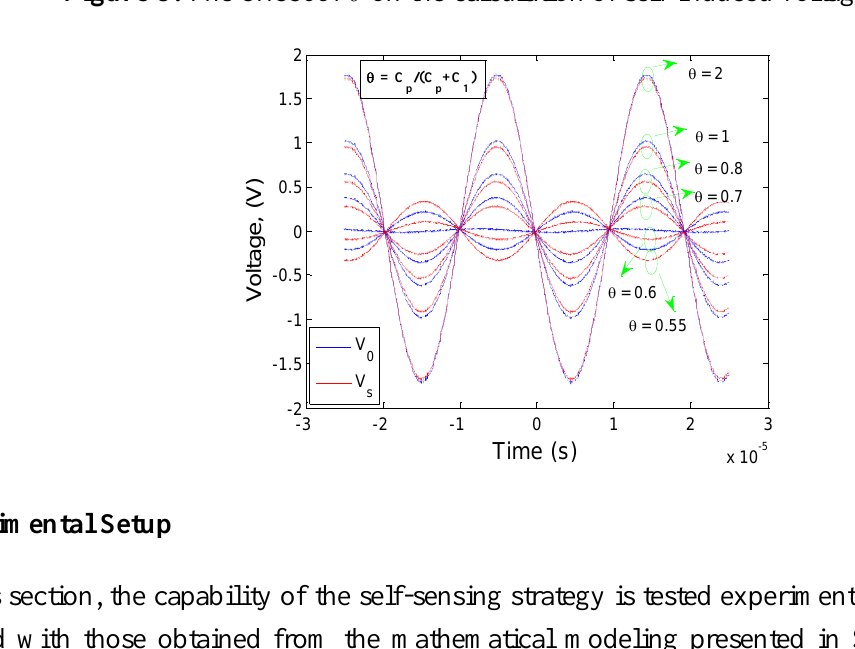
Figure 8. The effect of θ on the calculation of self-induced voltage, .